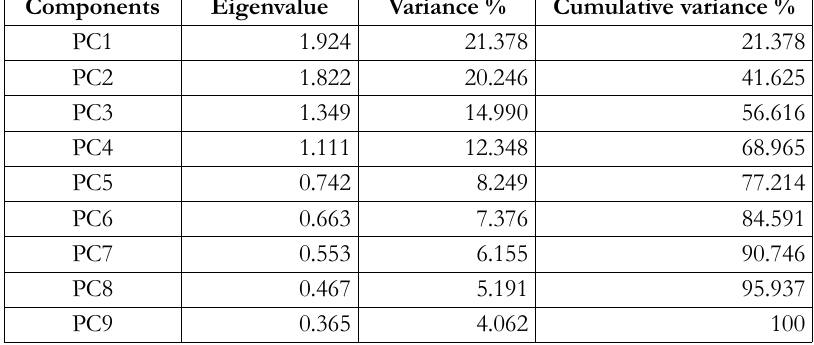
Table 4. Contribution of variables (questions) in the